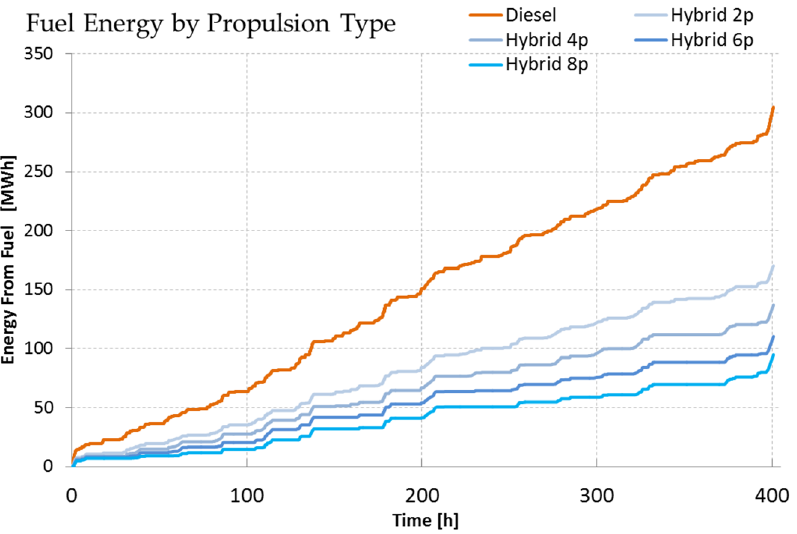
Figure 14. Plot of energy consumed from fuel for various powertrain configurations on the same test route: Diesel, Hybrid 2p, Hybrid 4p, Hybrid 6p, Hybrid 8p.